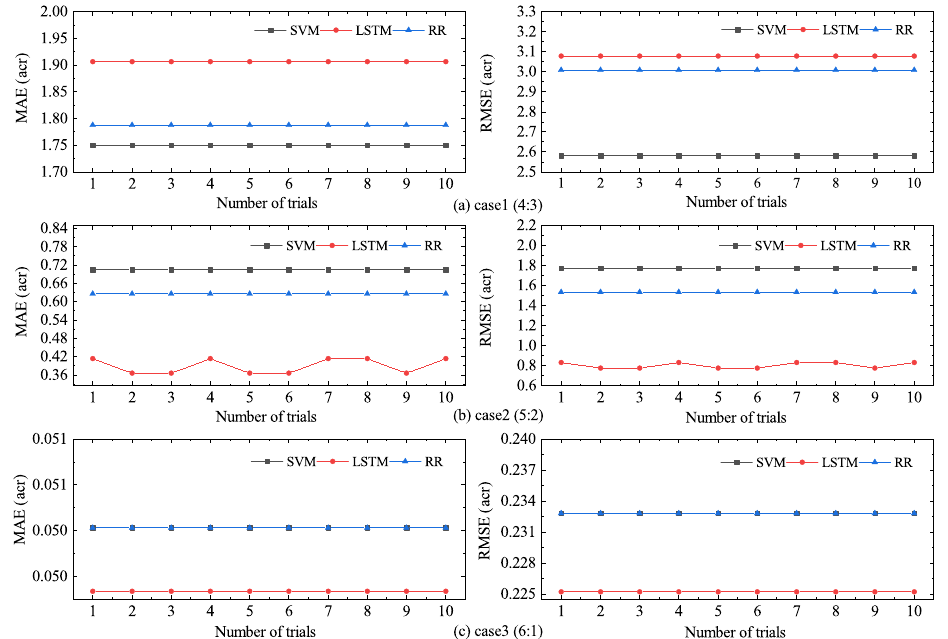
Figure 8. Prediction performance of models. The average error of model prediction is reported in Table